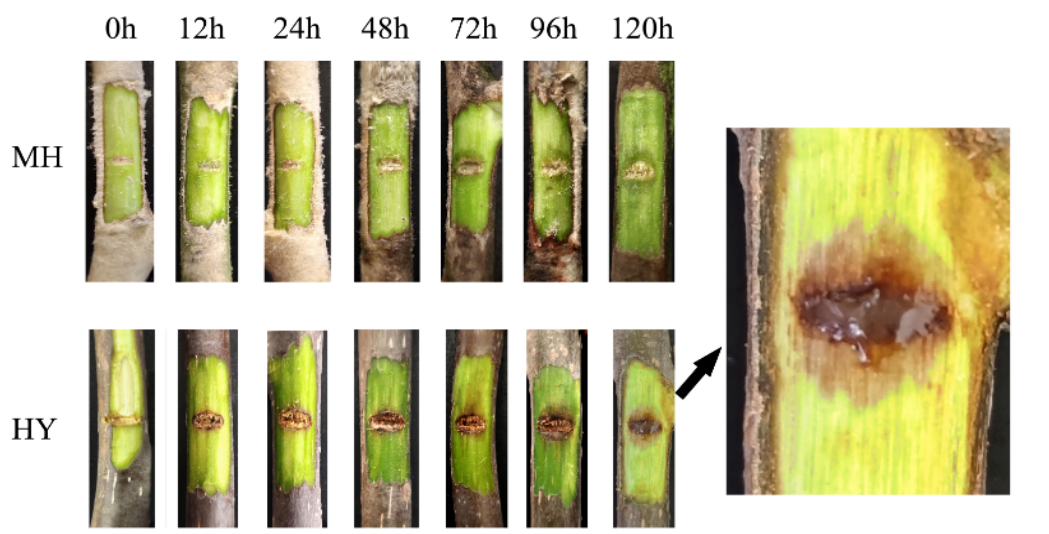
Figure 1. The phenotypic changes of disease symptoms in Actinidia MH and HY at 0, 12, 24, 48, 72, 96, and 120 hai (hours after inoculation) with Psa.